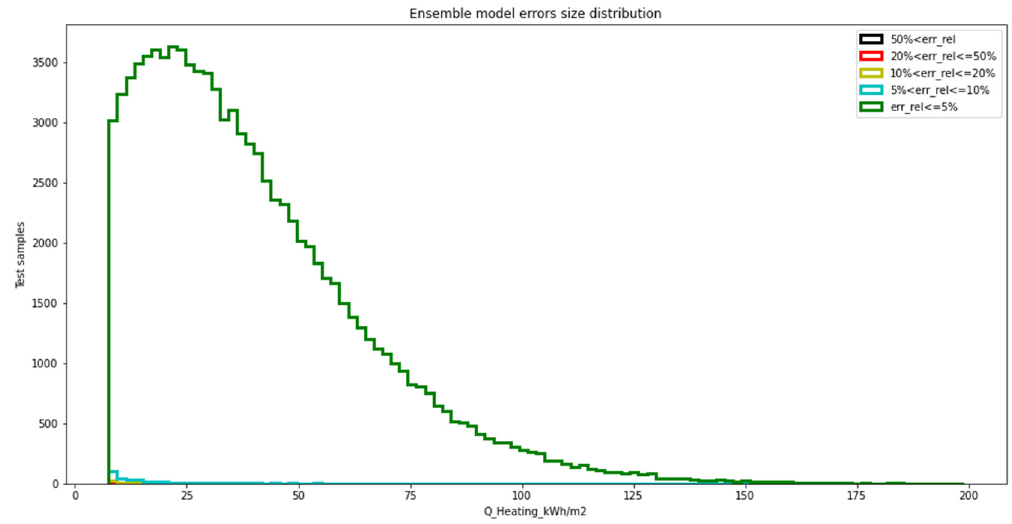
Figure 5. Frequency of occurrence for values of yearly heating energy demand intensity after transformation of the output values into a quasi-normal distribution.